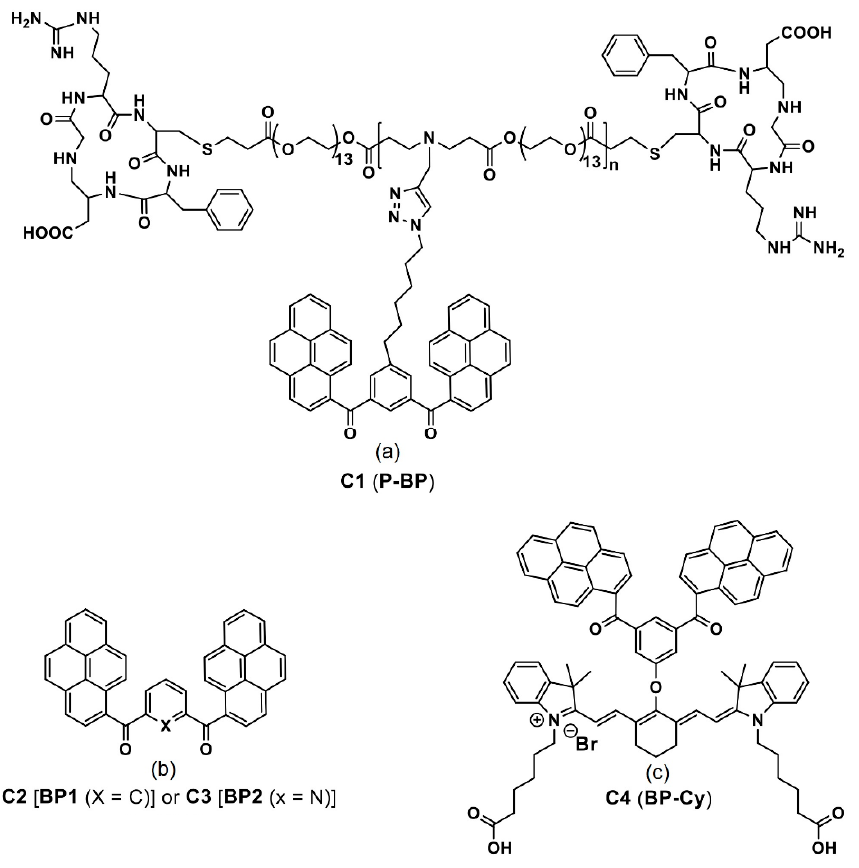
Figure 3. ( a – c ) C1 – C4 are the chemdraw structures of bis-pyrene-conjugated polymers, small molecules and dyes molecules (Note: the original representation or numbering of the molecules were provided in the brackets along with respective reference numbers).